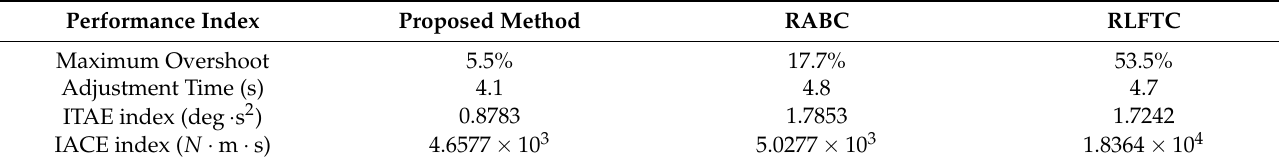
Table 3. Performance indexes of the σ